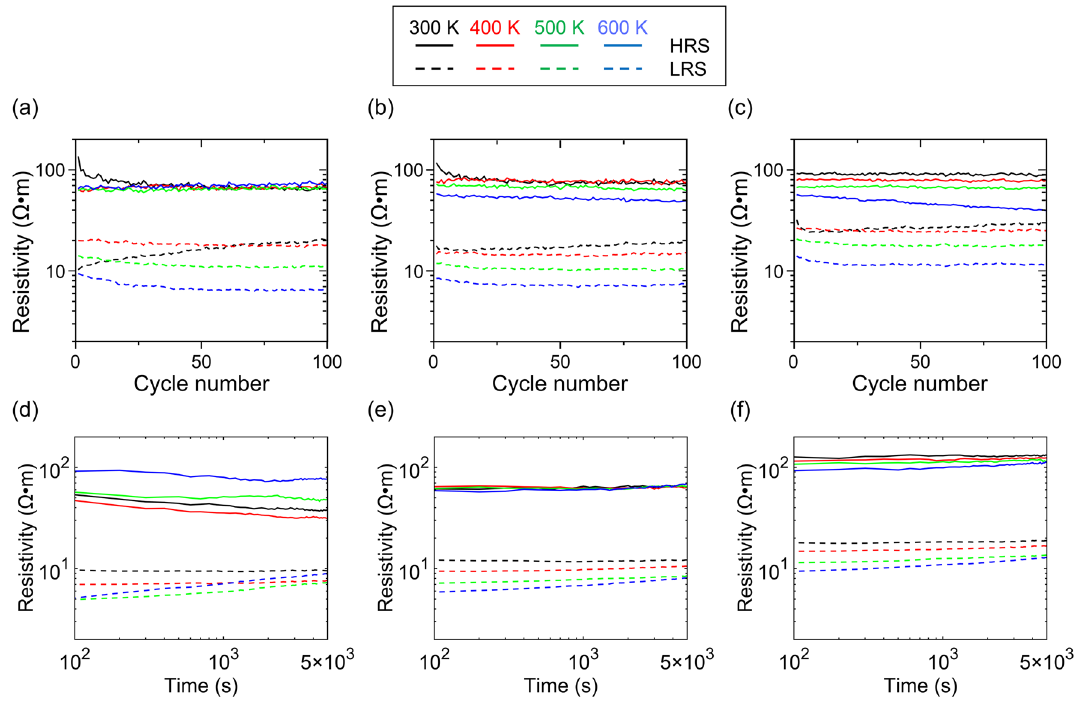
Figure 4. Temperature-dependent properties from 300 to 600 K. I–V sweep repeatability of samples ( a ) G05, ( b ) G10, and ( c ) G15, and retention properties of samples ( d ) G05, ( e ) G10, and ( f )